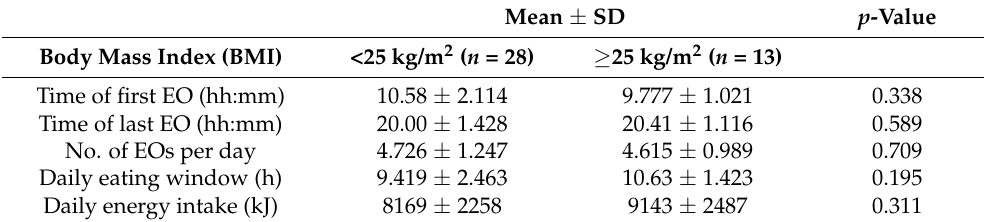
Table 4. Associations between eating pattern metrics and Body Mass Index (BMI, kg/m 2 ).